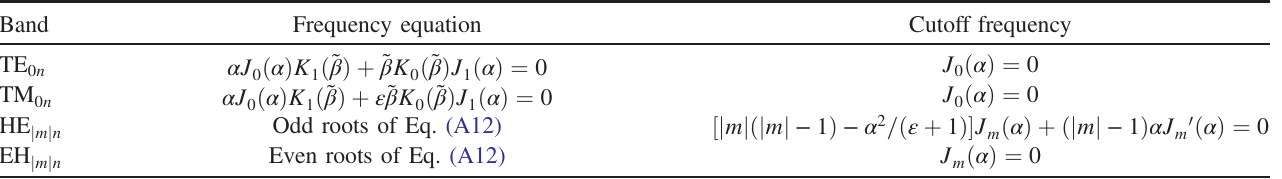
TABLE VII. Guided modes: Frequency equations and cutoff frequencies in terms of the quantities defined in Table III. The roots of these equation form discrete bands in the ð k; ω Þ plane as shown in Fig.